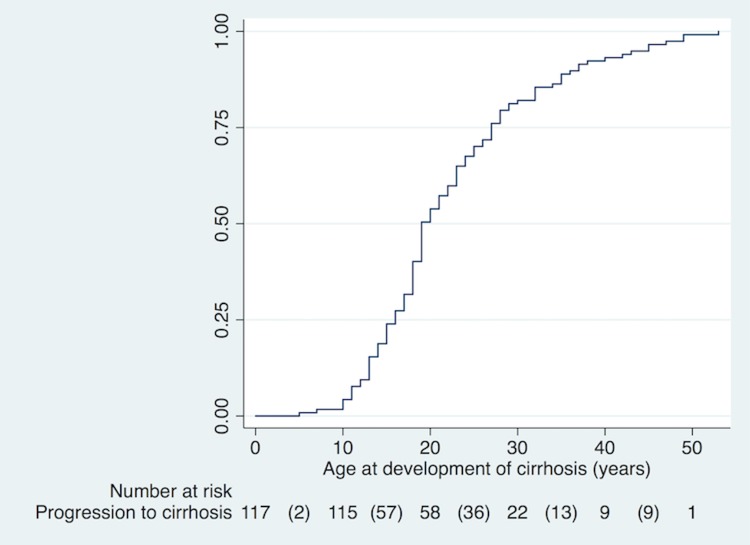
Cumulative frequency of progression to cirrhosis in patients with CFLD, by age (years).117 CFLD patients developed progressive disease and liver cirrhosis during the study, at a median age of 19 years (IQR 16 to 27 years).